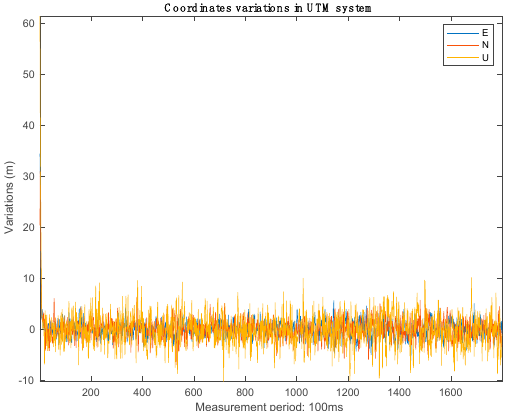
14 of 16 Figure 15. Frequency lock indicator calculated for PRN 19. 4.4. Navigation Solution Results